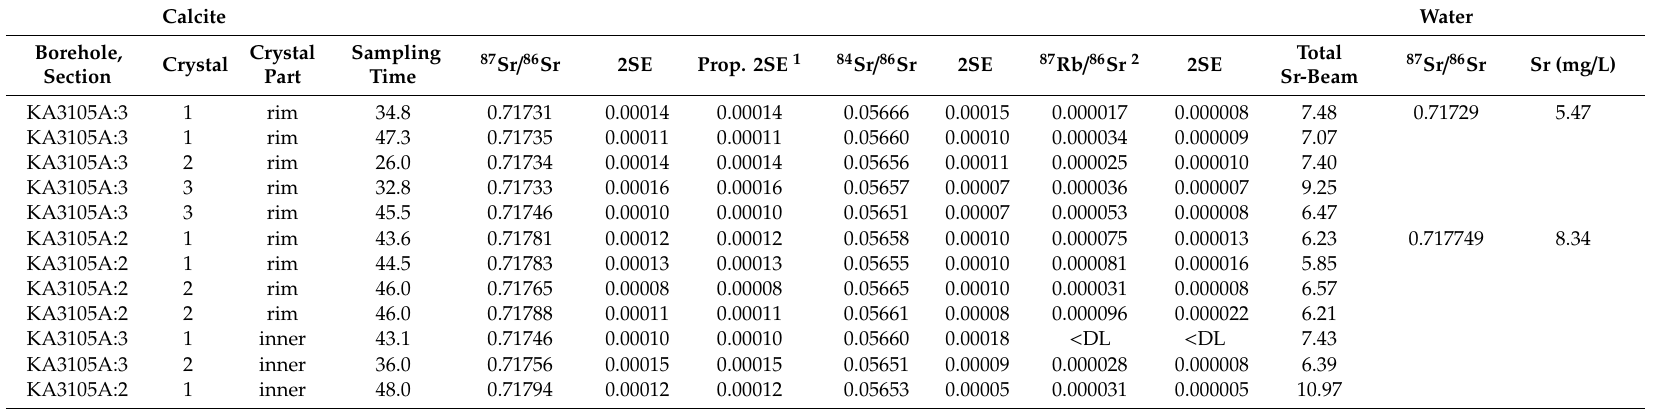
Table 1. Äspö HRL modern calcite ( n = 12).